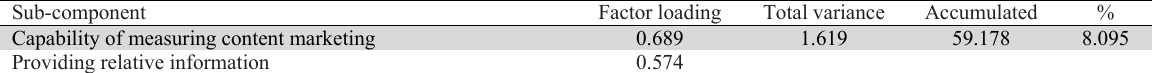
The summary of the sub-component influencing on details of content marketing Sub-component Factor loading Total variance Accumulated Capability of measuring content